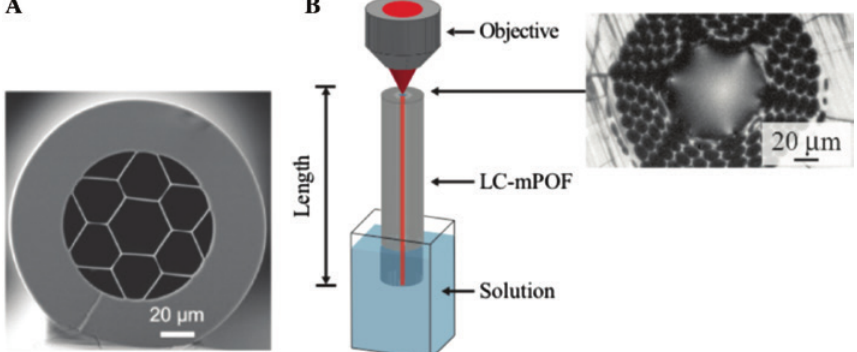
Figure 9: Cross sections of a novel silica air-clad hollow-core fiber (A) and polymer optical hollow-core fiber (B) for FERS sensing. (A) SEM image of the cross-section of an air-clad fiber which was developed specifically for highly sensitive drug monitoring. The diameter of the central core is approximately 30 μ m. (B) Experimental setup for FERS for glucose sensing. The microstructure of the polymer hollow- core optical fiber is modified on one end: all openings but the central core are closed. This end is dipped into the sample solution which is sucked into the central core as a result of the capillary effect. Laser coupling and signal collection through an objective lens takes place at the other end of the fiber. The inset shows a microscope image of the upper end face of the micro-structured polymer hollow-core optical fiber. Adapted from Yan et al. [107] (A) and from Azkune et al. [102] (B), reproduced with the kind permission of the American Chemical Society, Copyright (2018) American Chemical Society (A) and IEEE